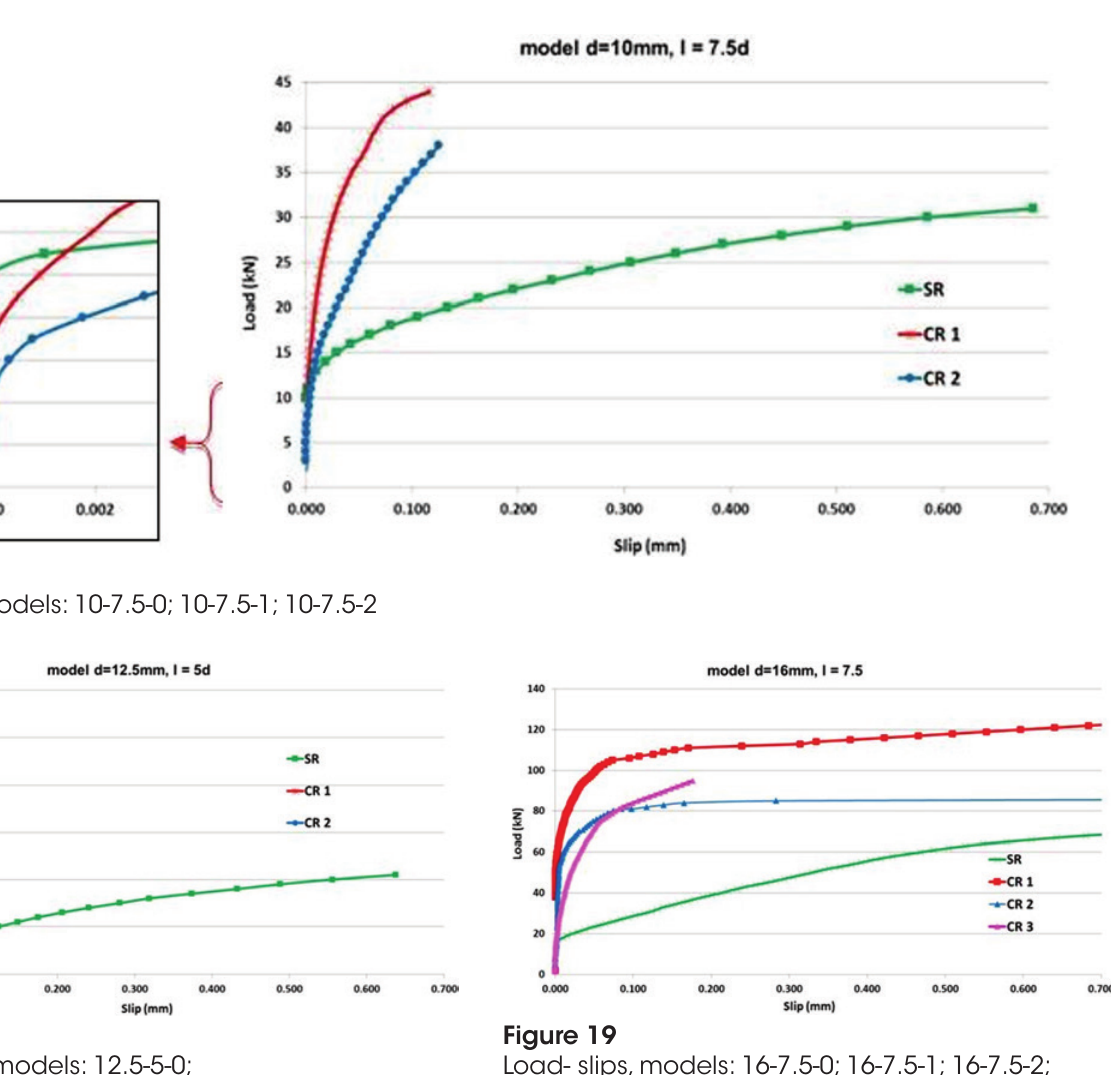
Load - slips, models: 12.5-5-0; 12.5-5-1; 12.5-5-2